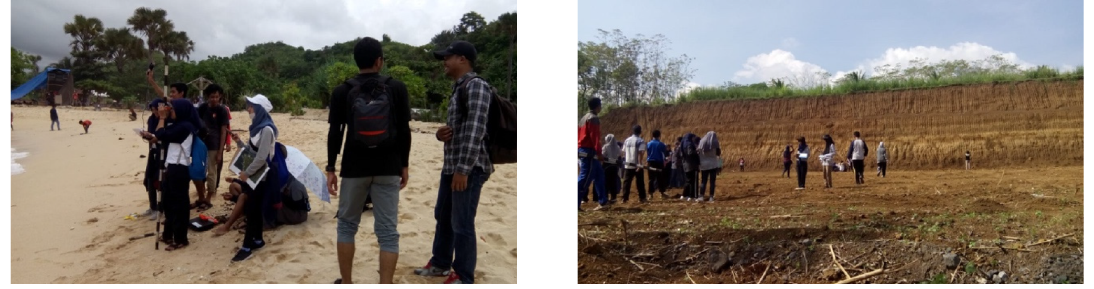
Figure 1. Student Activity in Experiment groups